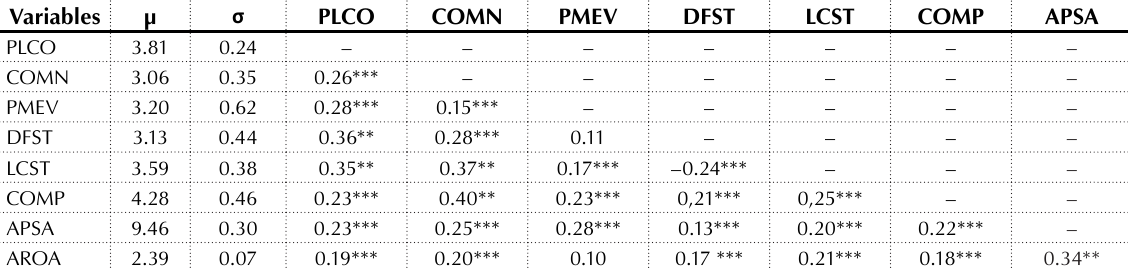
Table 2. Pearson correlations (one-way) Variables